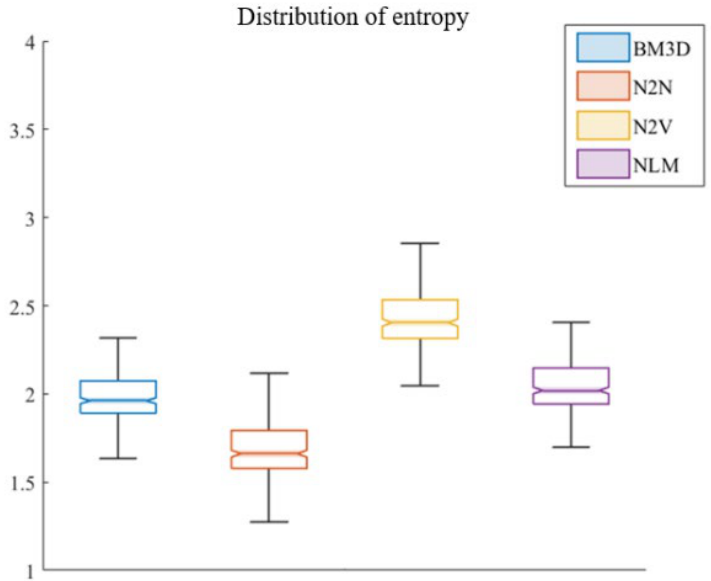
Figure 5. Distributions of entropy for BM3D, NLM, N2N and N2V results